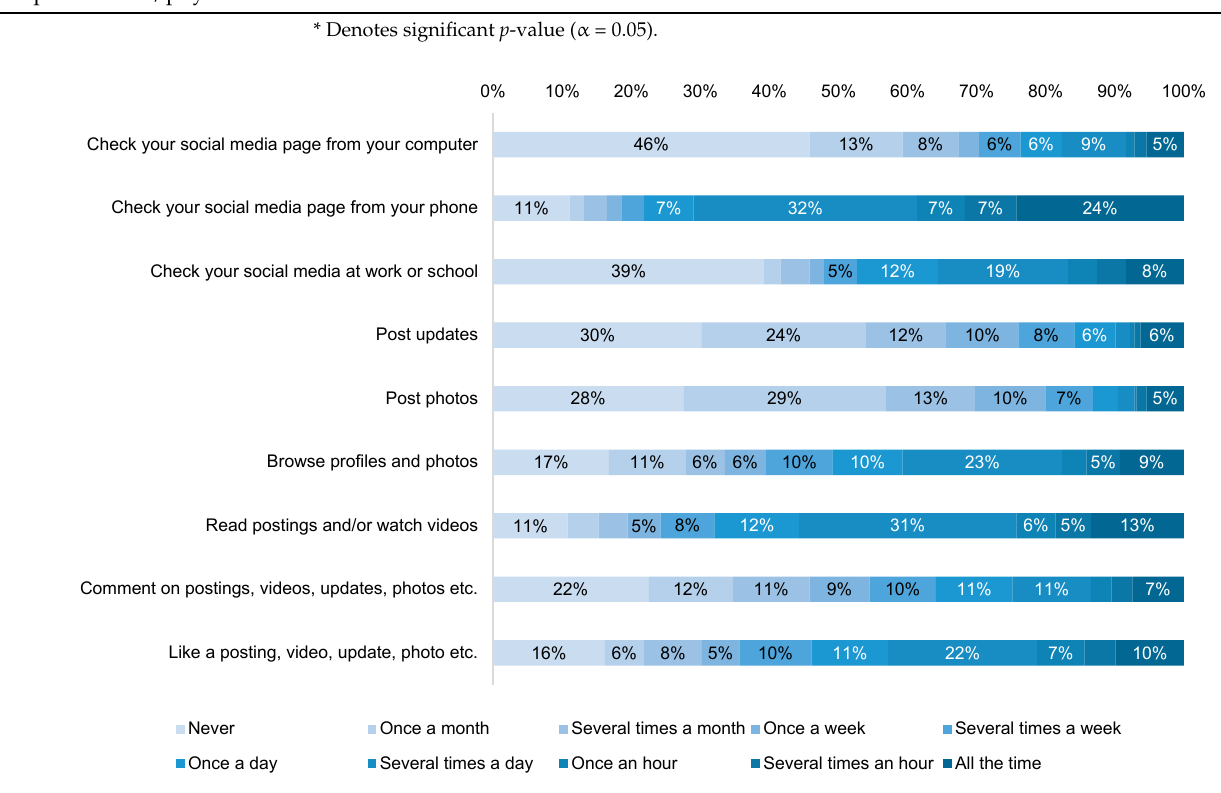
Figure 3. Responses to the Media and Technology Usage and Attitudes Scale (MTUAS) General Social Media Usage Subscale. Note: Values are represented as a percentage of the overall total ( n = 334), and data labels for response values lower than 5% have been excluded from this